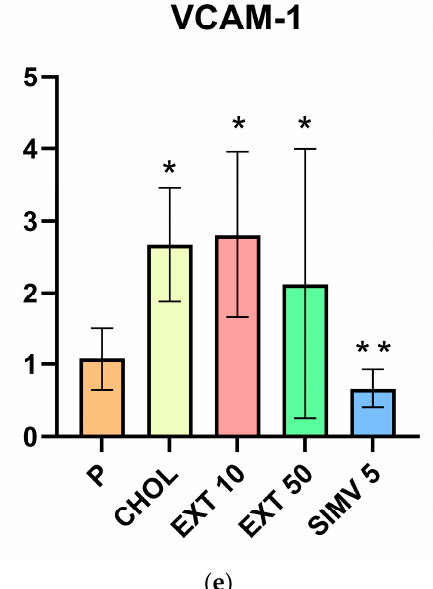
Figure 1. mRNA expression of MMP-1, MMP-9, IL-6, NOX, and VCAM-1 in the aorta. ( a ) MMP-1, ( b ) MMP-9, ( c ) IL-6, ( d ) NOX, and ( e ) VCAM-1. P—standard chow; CHOL—standard chow + 1% cholesterol; EXT 10—standard chow + 1% cholesterol + Cornelian cherry extract 10 mg/kg bw; EXT 50—standard chow + 1% cholesterol + Cornelian cherry extract 50 mg/kg bw; SIMV 5—standard chow + 1% cholesterol + simvastatin 5 mg/kg bw Values are presented as mean ± SD. * p < 0.05 vs. P. ** p < 0.05 vs. CHOL.